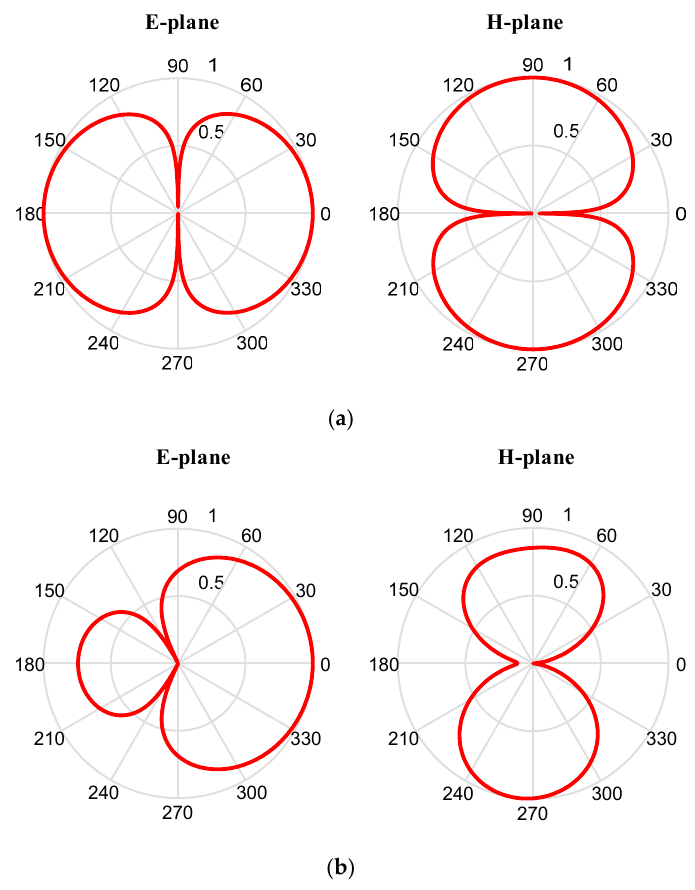
Figure 14. Comparison of radiation characteristic of two antennas: ( a ) The simulated E plane, H plane and 3D radiation pattern belong to the antenna without reflection cavity construction; ( b ) The simulated E plane, H plane and 3D radiation pattern belong to the antenna with cavity construction.